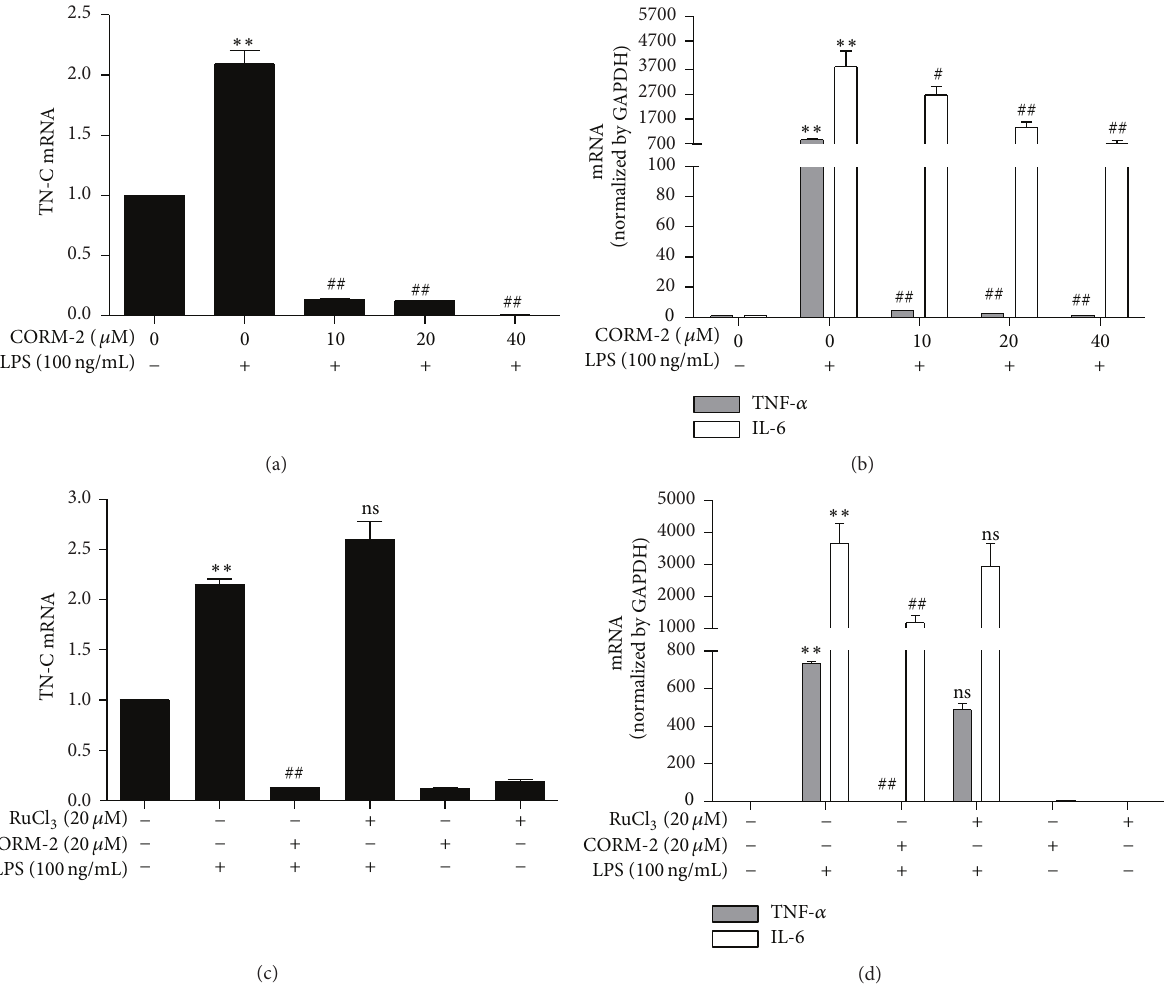
Figure 3: CO inhibits LPS-induced TN-C expression and proinflammatory cytokines in peritoneal macrophages. (a-b) Macrophages were pretreated with CORM-2 (0, 10, 20, and 40 𝜇 M) for 1h and then stimulated with LPS (100ng/mL) for 8h. TN-C, TNF- 𝛼 , and IL-6 mRNA levels were detected by Real Time RT-PCR, respectively. (c-d) Cells were pretreated with CORM-2 (20 𝜇 M) or RuCl 3 (20 𝜇 M) for 1h and stimulated with or without LPS (100ng/mL) for 8h. RuCl 3 was used as a negative control for CORM-2. TN-C, TNF- 𝛼 , and IL-6 mRNA levels were detected by Real Time RT-PCR. Data represents mean ± SEM, ∗∗ 𝑃 < 0.001 as compared with control; # 𝑃 < 0.05 , ## 𝑃 < 0.001 , and ns, nonsignificant, as compared with the cells exposed to LPS